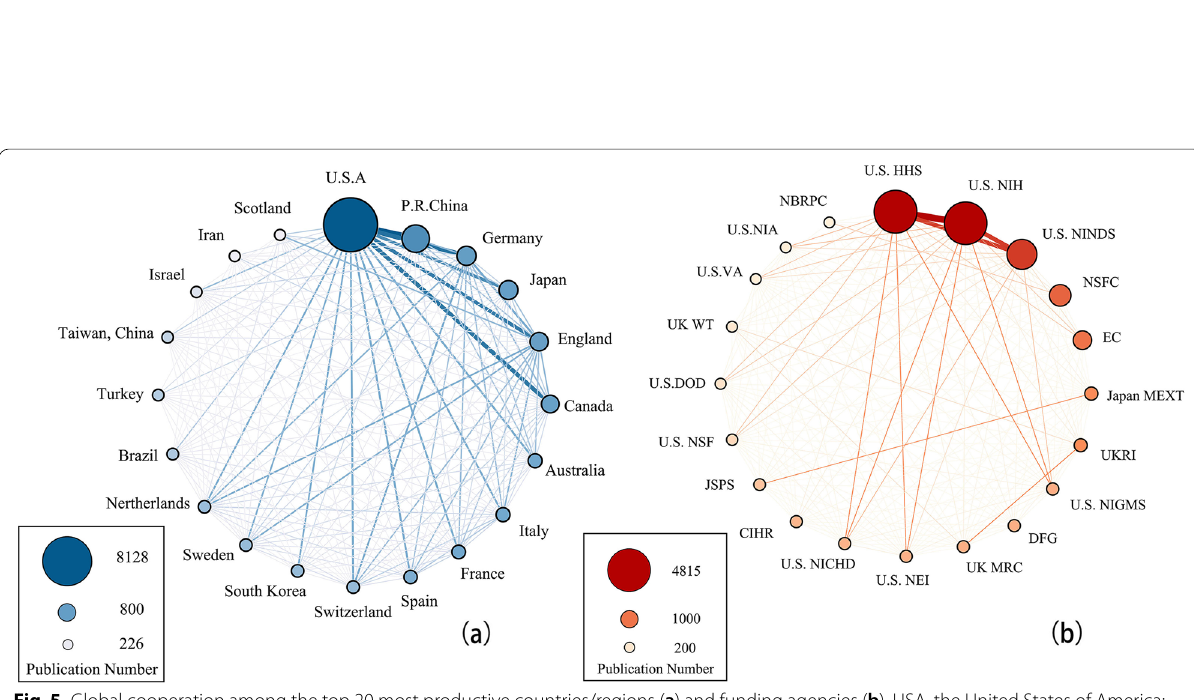
Fig. 5 Global cooperation among the top 20 most productive countries/regions ( a ) and funding agencies ( b ). USA, the United States of America; P. R. China, People’s Republic of China; US HHS, United States Department of Health Human Services; US NIH, United States National Institutes Of Health; US NINDS, United States National Institute of Neurological Disorders Stroke; NSFC, National Natural Science Foundation of China; EC, European Commission; Japan MEXT, Japan Ministry of Education Culture Sports Science and Technology; UKRI, UK Research Innovation; US